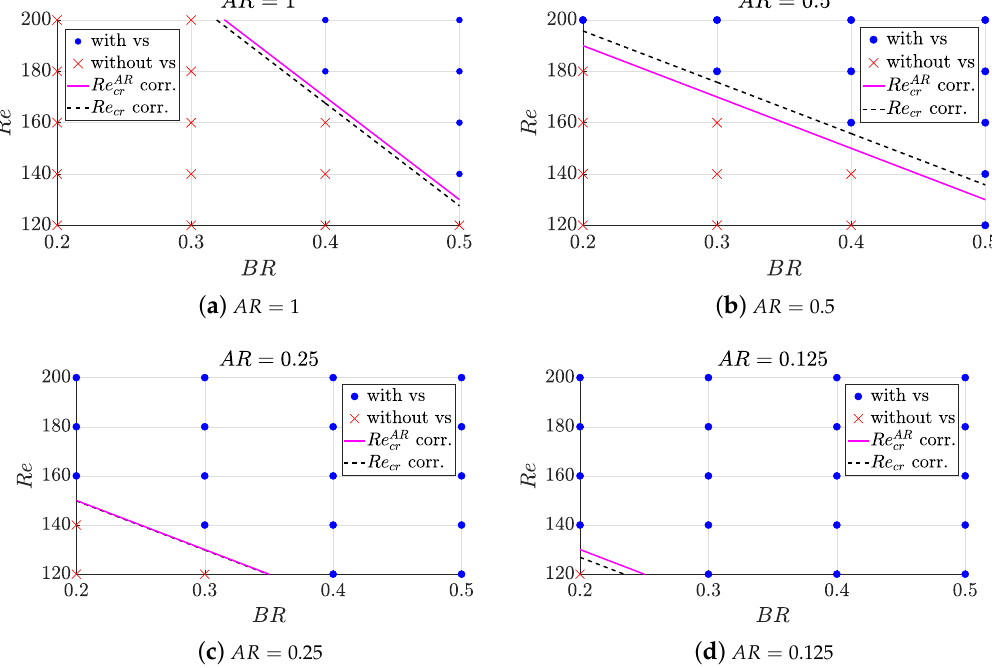
Figure 4. Impact of Reynolds number and geometry on the existence of vortex shedding (vs).